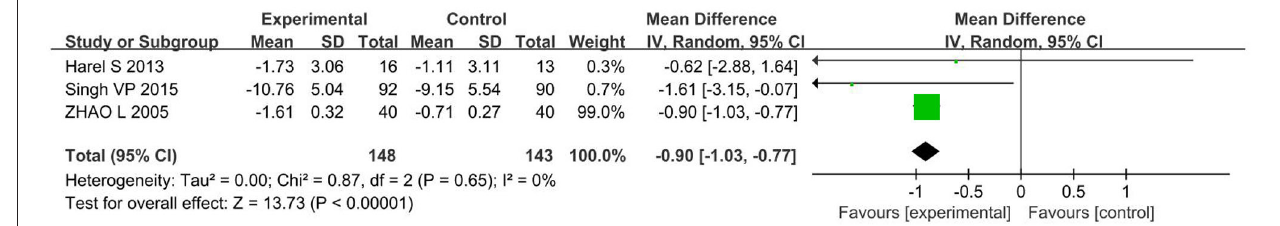
FIGURE 5 | The effects of art therapy on blood glucose level.